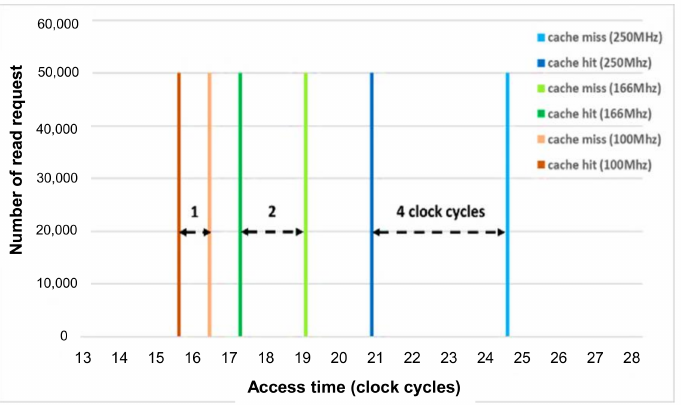
Figure 8. The effect of frequency on the